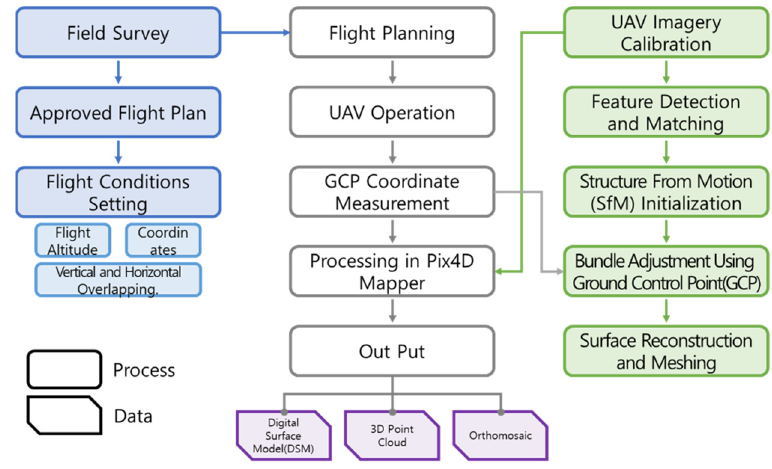
Figure 1. Flow chart for unmanned aerial vehicle (UAV) processing.